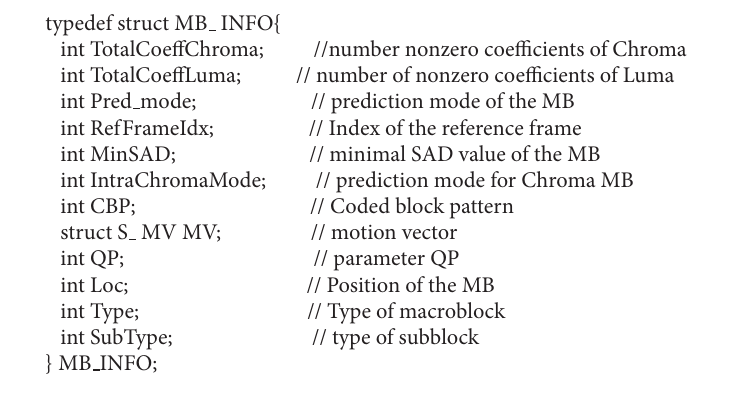
Algorithm 1: Structure of the MB INFO structure in the x264